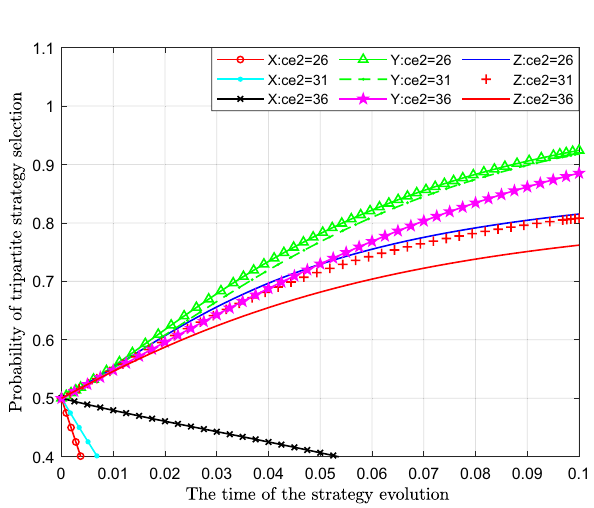
Figure 5. Effect of changes in excessive emission costs of sewage